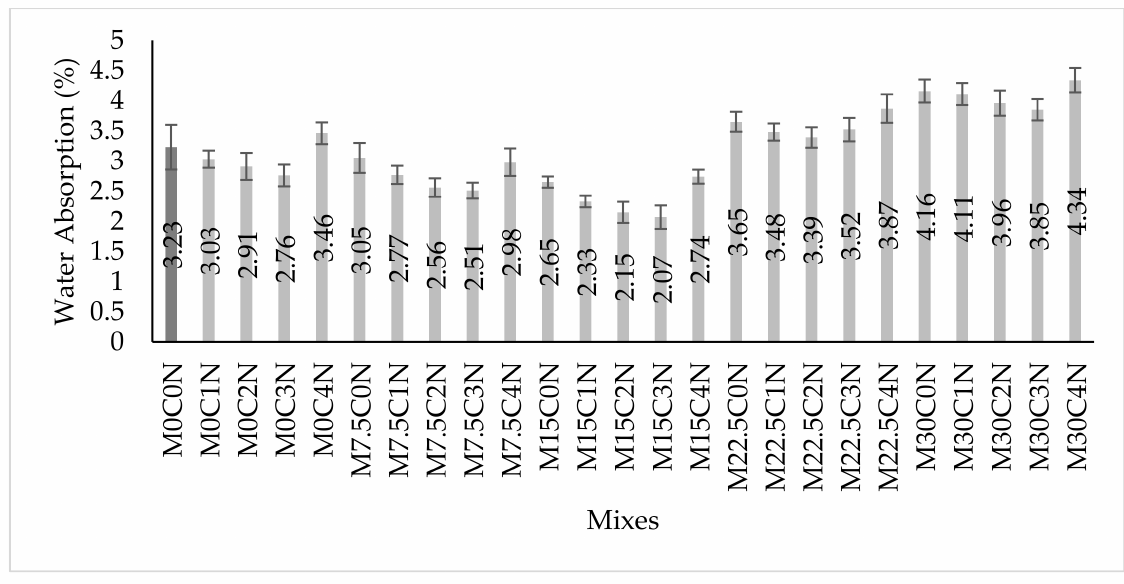
Figure 13. Relationship between Compressive Strength and Modulus of Elasticity.